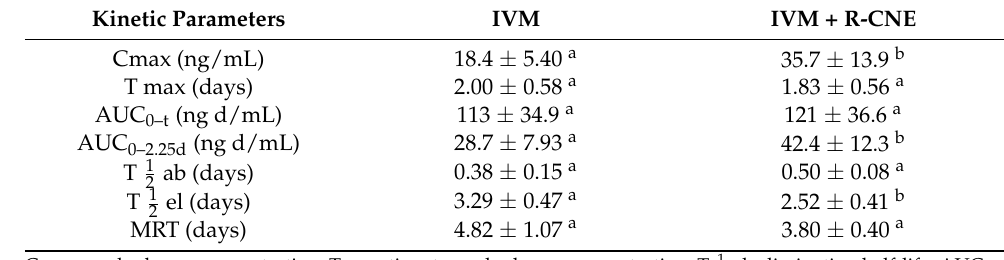
Cmax, peak plasma concentration; Tmax, time to peak plasma concentration; T 1 area under concentration vs. time curve from time 0 to the last concentration detected; AUC 0–2.25d , area under concentration vs. time curve from time 0 to 2.25 days; MRT, mean residence time. Different letters between treatments for values of kinetic parameters denote a statistically significant difference at p ≤